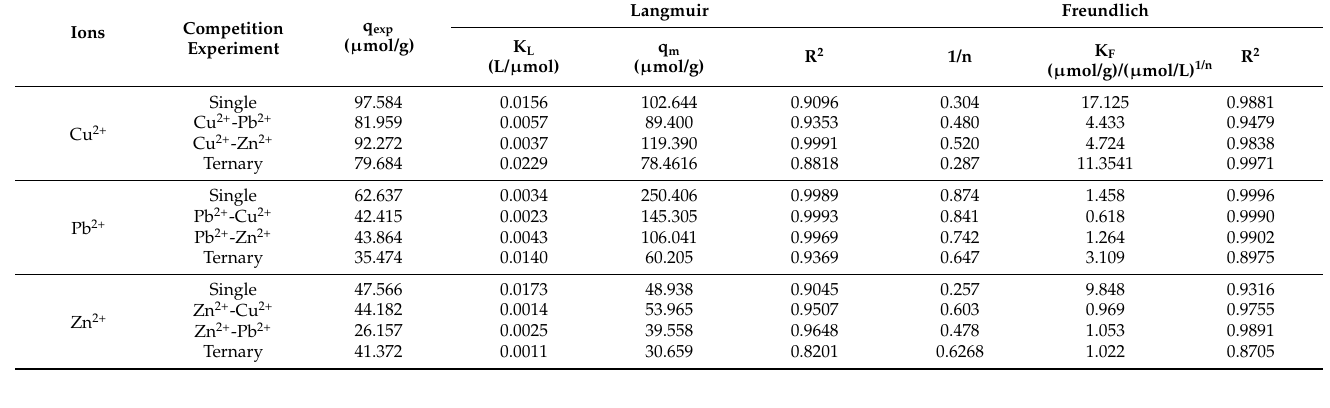
Table 5. Isothermal model fitting parameters for Langmuir and Freundlich.